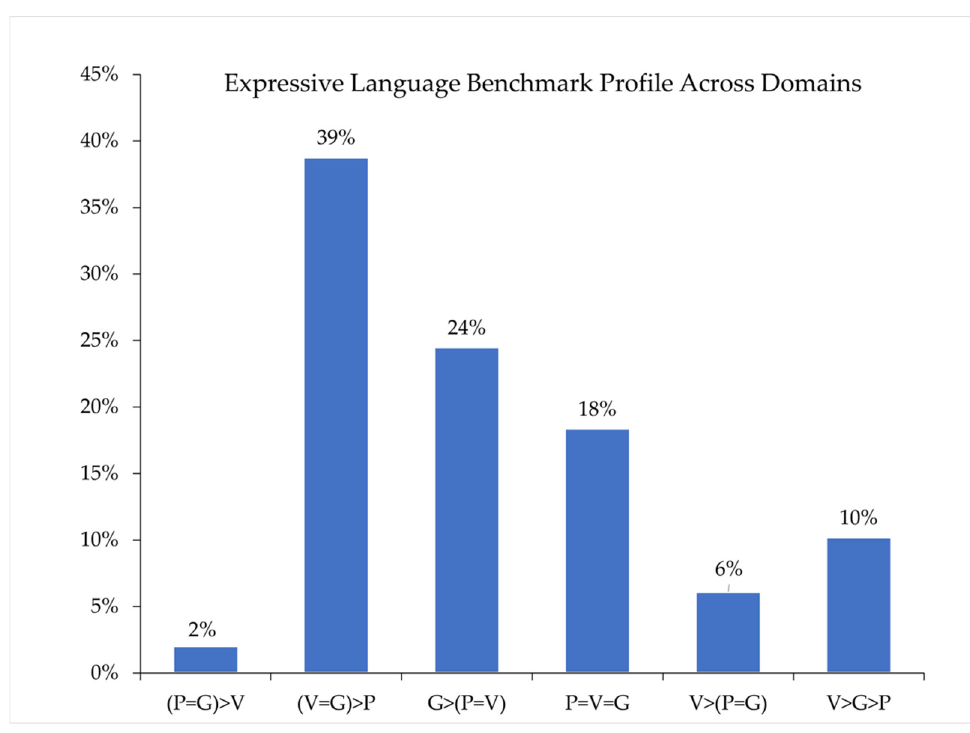
Figure 2. Expressive Language Benchmarks Profiles Across Language Domains ( n = 49). Note. P, phonology domain; V, vocabulary domain; G, Grammar domain; “=”, same benchmark; “>”, higher benchmark.